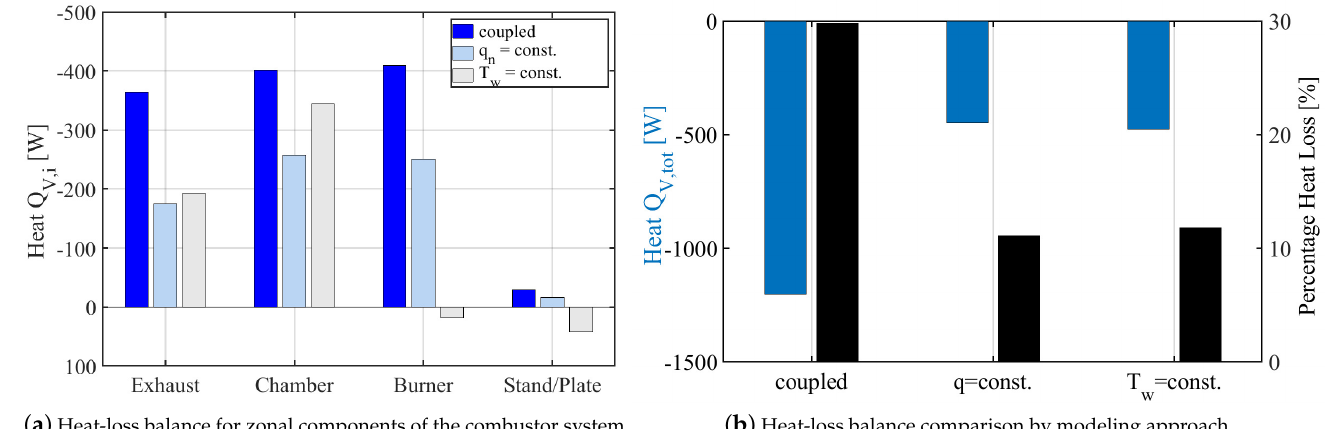
Figure 8. Heat loss balance based on numerical simulation approaches for isothermal, heat-flux, and coupled